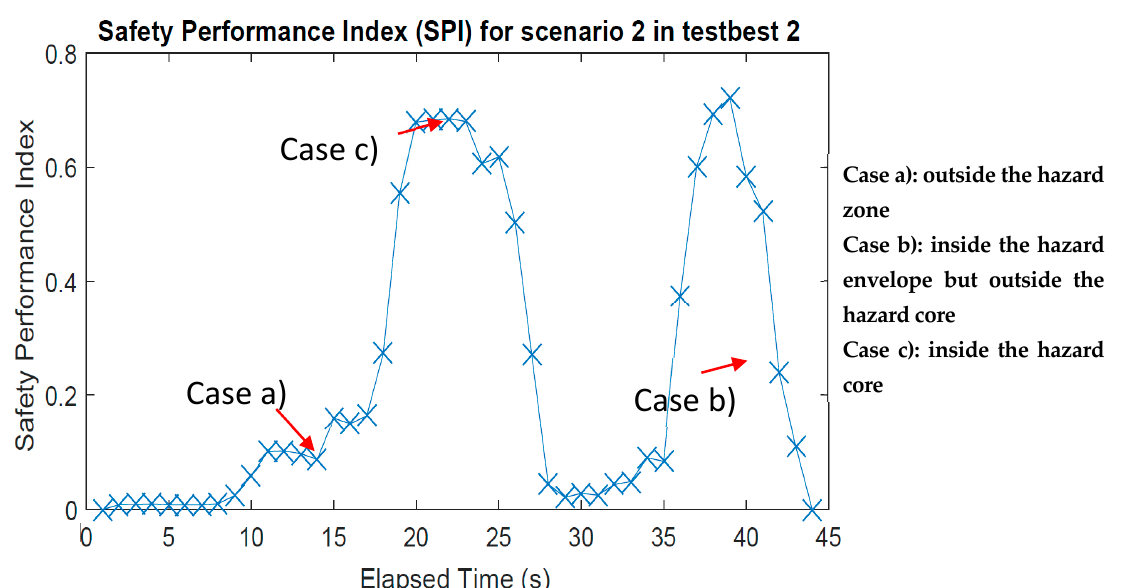
Figure 10. Safety performance index for Scenario 2 of Testbed 2.